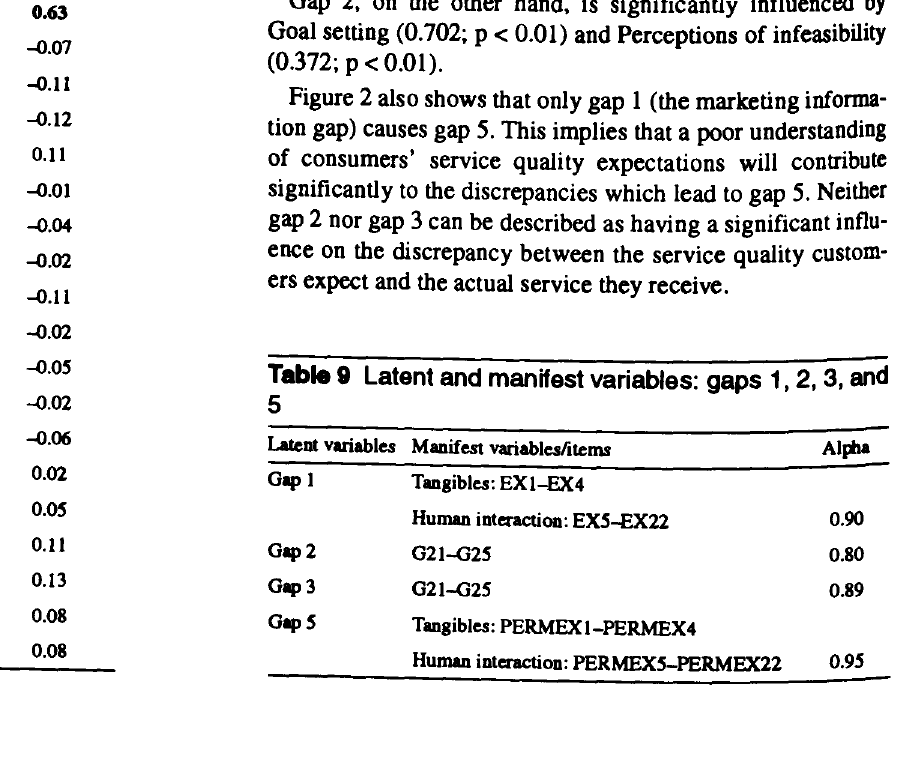
Table 9 Latent and manifest variables: gaps 1, 2, 3,